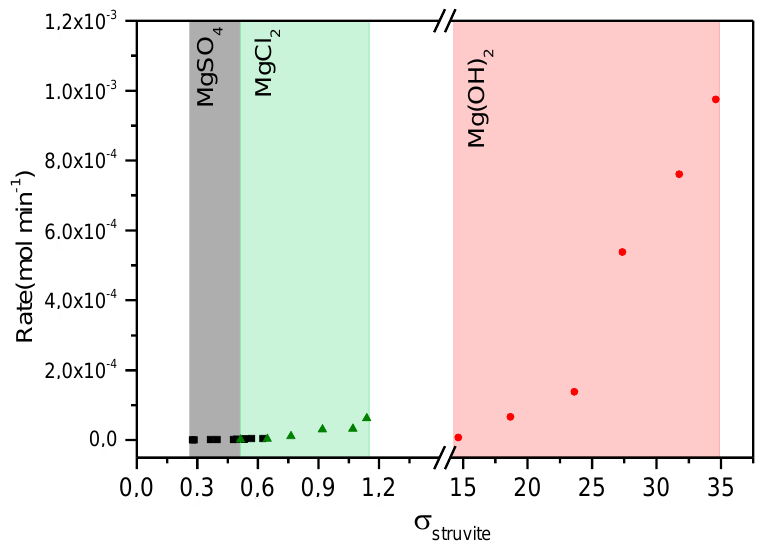
Figure 7. Comparison of precipitation rate of spontaneous struvite precipitation rates in its supersaturated solutions using as magnesium source: Mg(OH) 2 suspensions ( ⚫ );MgCl 2 [23] ( ▲ );MgSO 4 [29] ( ν ); 25 °C. The solid precipitated from the supersaturated solutions by both methods was struvite exclusively, as shown in the XRD diagrams shown in Figure 8.